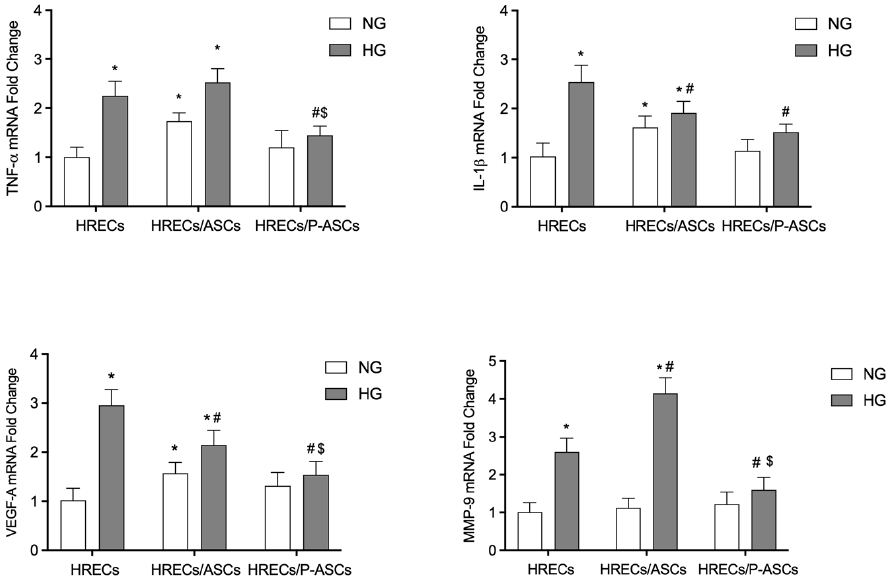
Figure 3. TNF- α , IL-1 β , and VEGF mRNA levels in cultures of human retinal endothelial cells (HRECs) alone and co-cultured with human adipose-derived mesenchymal stem cells (ASCs) or pericyte-like ASCs (P-ASCs). TNF- α , IL-1 β , and VEGF mRNA levels in HRECs were measured by qRT-PCR from samples that were cultured either in normal glucose (NG) or high glucose (HG) conditions. mRNA levels of each group were normalized to the housekeeping reference gene ribosomal 18S RNA. In the histograms, values are expressed as the fold change in those detected in HRECs cultured in NG conditions. Data indicate a modulation of inflammation genes in contrast to an HG-induced pro-inflammatory HREC phenotype. At the same time, decreases in pro-angiogenic factors were found. More evident effects were observed when HRECs were co-cultured with P-ASCs. Each value represents mean ± SEM obtained from three independent experiments. * p < 0.05 vs. HRECs in NG; # p < 0.05 vs. HRECs in HG; $ p < 0.05 HRECs/P-ASCs in HG vs. HRECs/ASCs in